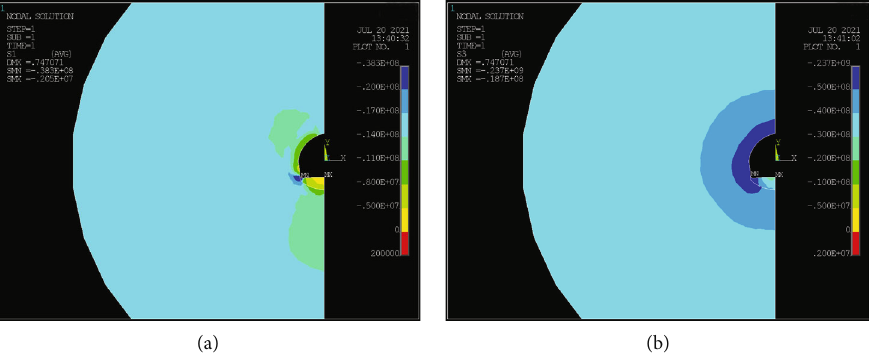
σ Figure 5: Maximum ( σ 1 ) (a) and minimum ( 3 ) (b) principal stresses around the roadway with the solution